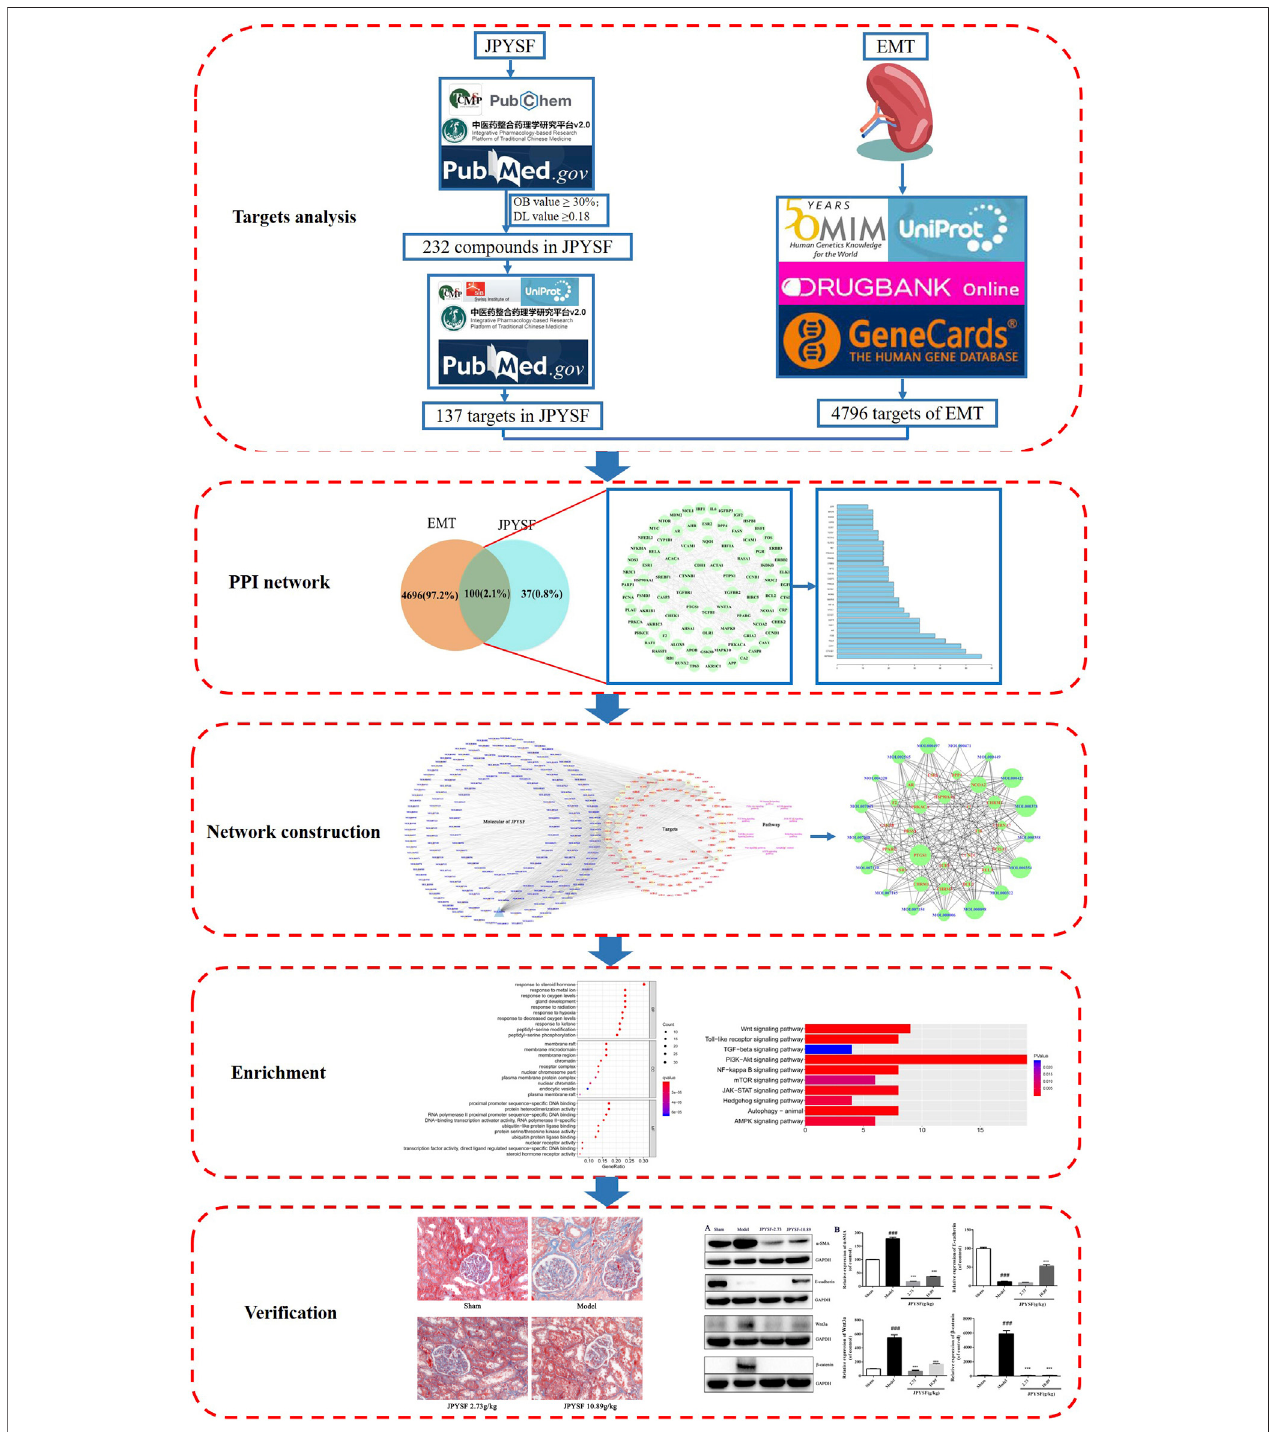
FIGURE 7 | The work fl ow of the system ’ s pharmacology analysis and experimental veri fi cation of Jian-Pi-Yi-Shen formula (JPYSF) in suppressing epithelial – mesenchymal transition (EMT).